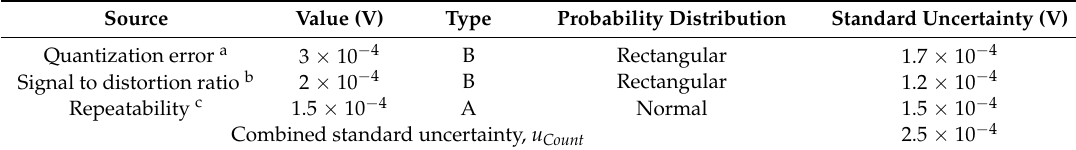
Table 4. Combined standard uncertainty for voltage measurement by the ADC component. Source Value (V) Type Probability Distribution Standard Uncertainty